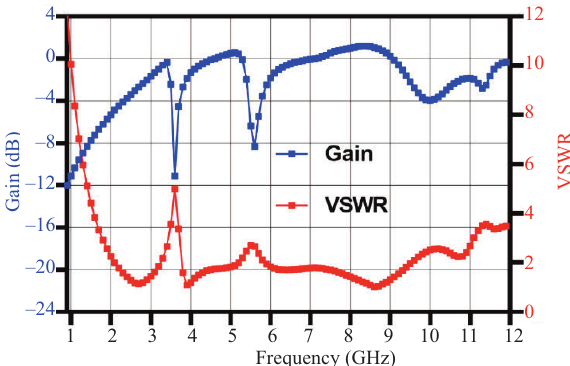
Fig. 6. Simulated VSWR and gain of the proposed antenna with two rejected bands.